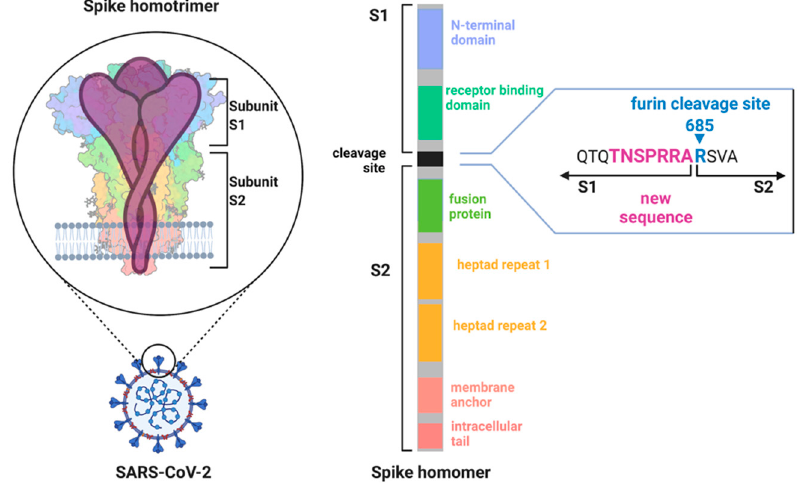
Figure 3. The SARS-CoV-2 spike protein expressed at the virus membrane forms a homotrimer. Each spike subunit can be further divided into two major subdomains (S1 and S2) that are separated by a cleavage site. This cleavage site can be targeted by the protease furin and was identified to include new amino acids (purple) in comparison to SARS-CoV. The inclusion of the new amino acids is considered to make this site more accessible to furin and to be a major reason for the increased transmissibility of SARS-CoV-2 (created by